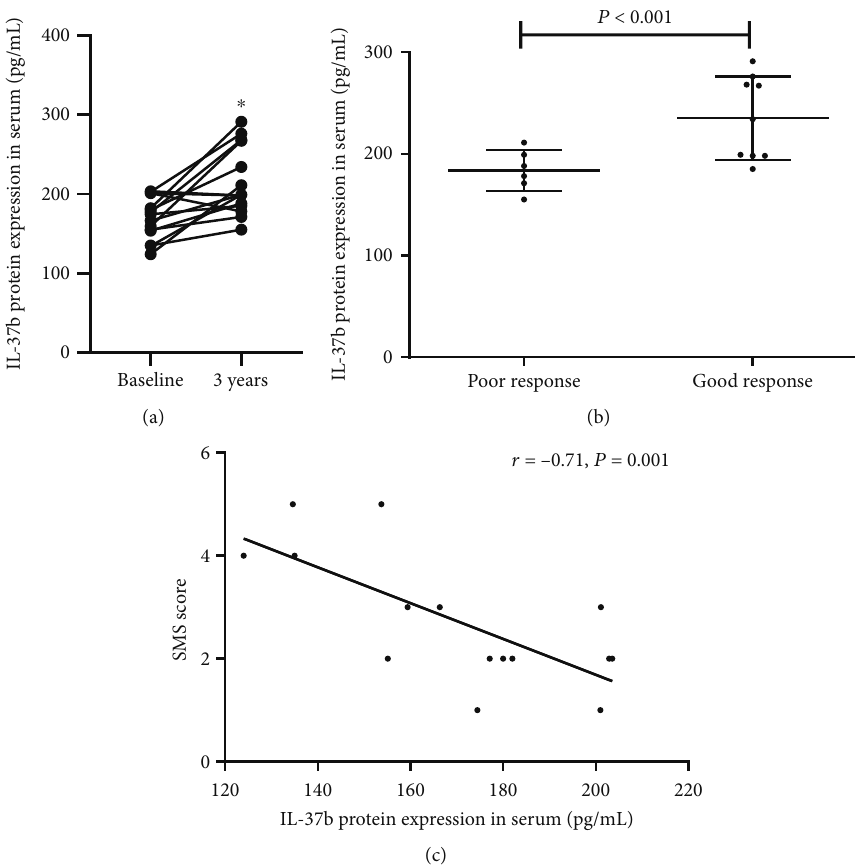
Figure 4: The protein expression of IL-37b during subcutaneous allergen immunotherapy. (a) The comparison of IL-37b protein expression between baseline and 3 years after SCIT. (b) The comparison of IL-37b protein expression between poor and good response groups 3 years after SCIT. (c) The correlation between IL-37b protein expression and disease severity. SMS: symptom medication score; SCIT: subcutaneous allergen immunotherapy. ∗ Compared with the baseline group, P < 0 : 05